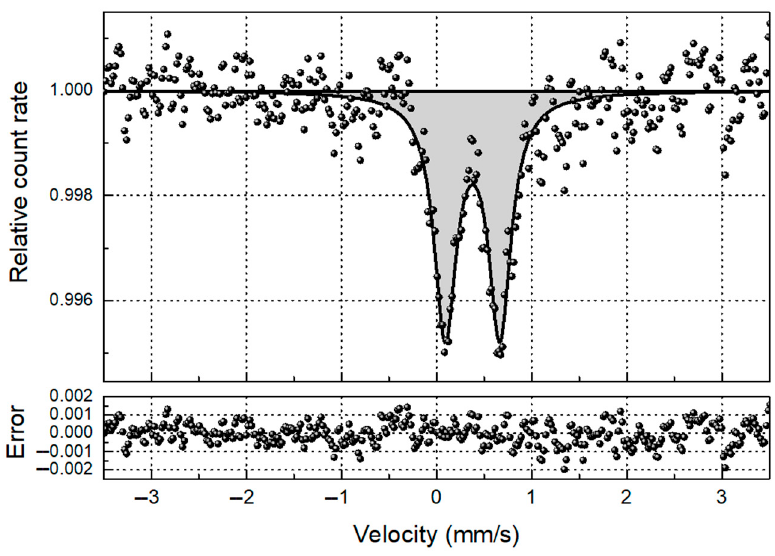
Figure 9. 57 Fe Mössbauer spectra of the Bi 2 Fe 0.5 Mg 0.5 Ta 2 O 9.5- Δ in the paramagnetic region.